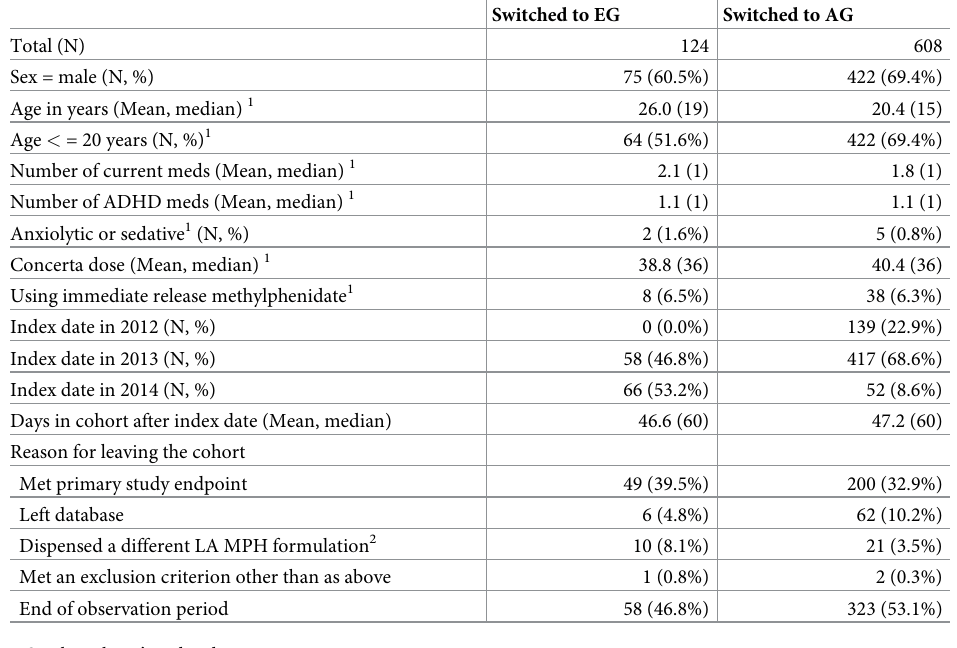
Table 2. Selected characteristics of the study cohort by study arm (AG or EG).